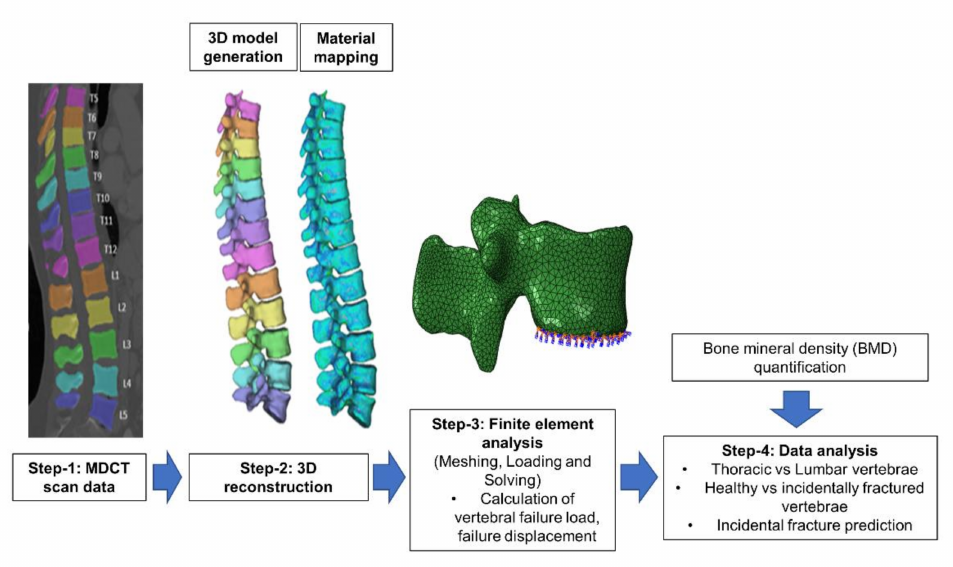
Figure 2. Modelling and analysis methodology followed in the current computational study for identifying incidental